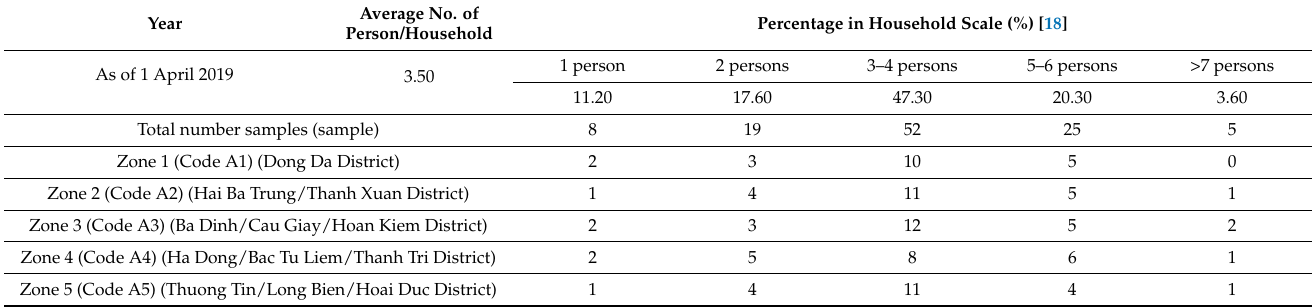
Table 1. Number of samples in specified